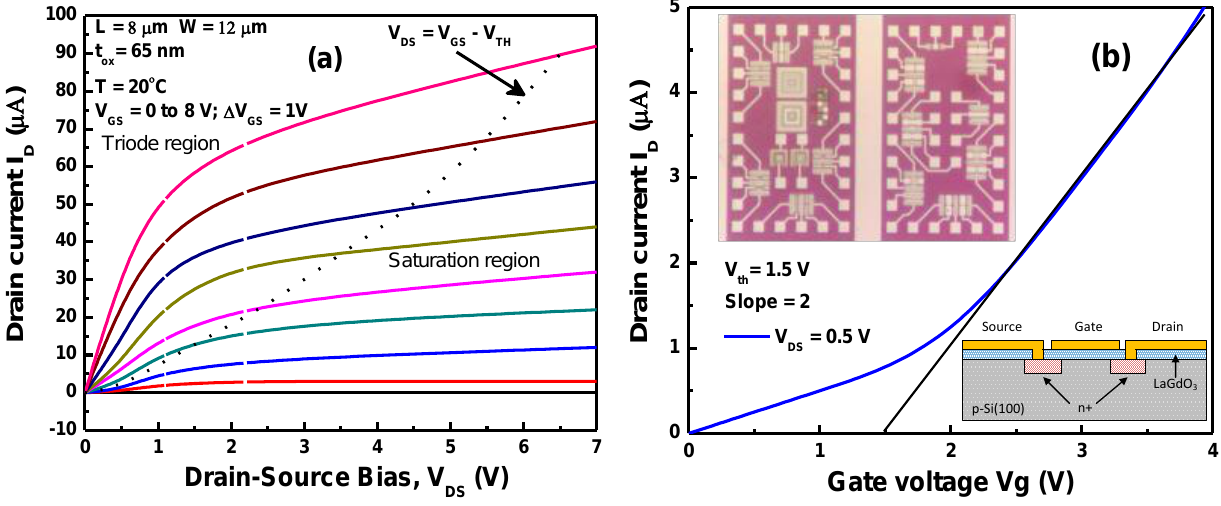
Figure 17. ( a ) Drain current I vs. drain to source voltage V characteristics for LaGdO DS DS 3 gated n-metal-oxide field effect transistor (n-MOSFET) for various gate voltages; ( b ) sub-threshold I - V characteristic for an n-MOSFET device. The inset shows the D GS layout of MOSFET structures on the p-Si wafer with gate lengths between 5 and 50 μm (top) and their schematic layout